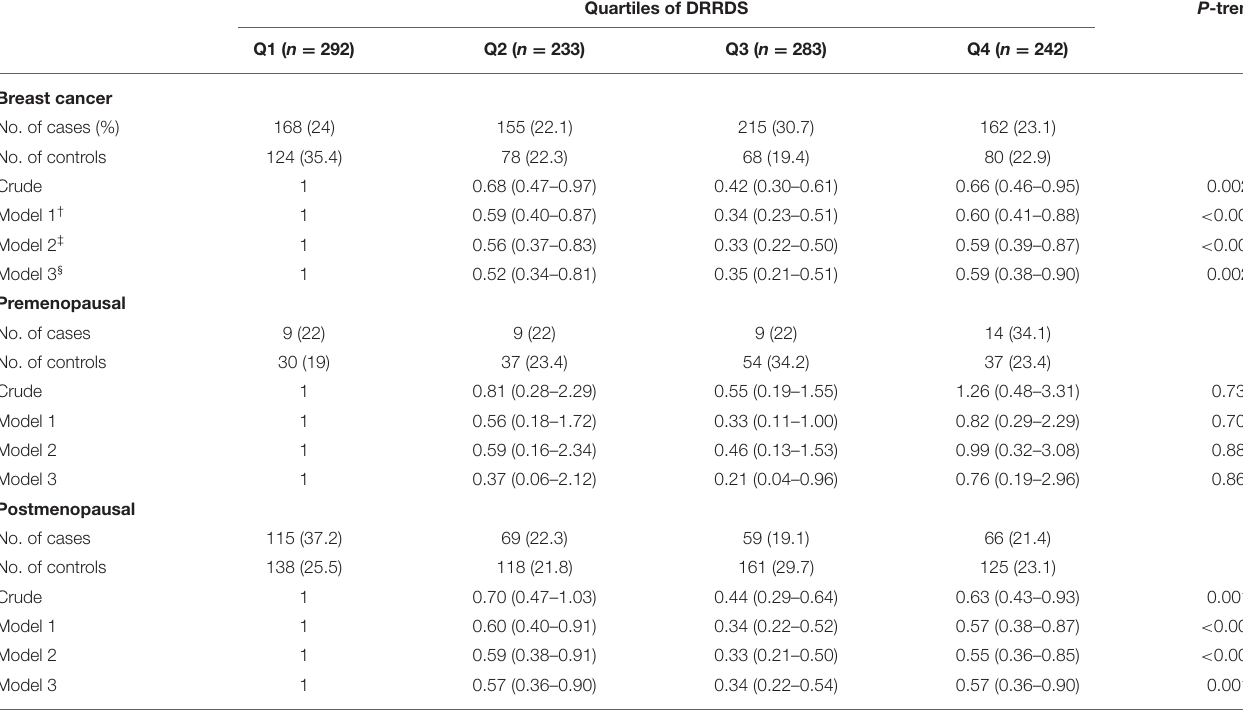
TABLE 4 | Multivariable-adjusted odds ratios (95% CIs) for breast cancer across quartile categories of DRRDS, stratified by menopausal status. Quartiles of